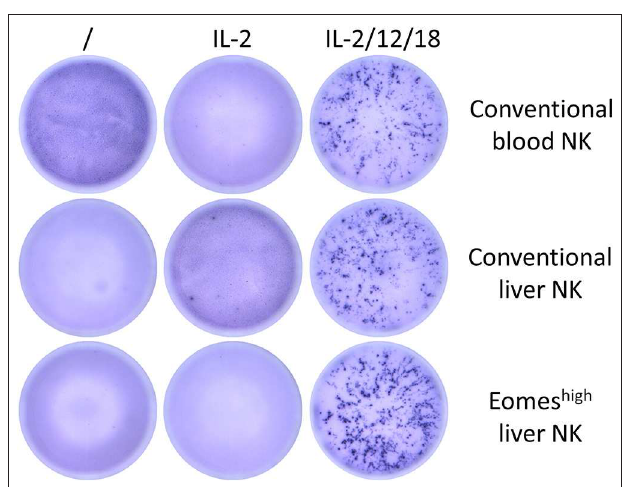
FIGURE 4 | IFN- γ production of conventional blood and liver NK cells or Eomes high liver resident NK cells upon stimulation with IL-2/12/18. After NK isolation, 1.25 × 10 4 NK cells/well were cultivated without stimulation or with different cytokine mixes for 20 or 38h and analyzed by ELISpot for their IFN- γ production. Picture shows data for one representative animal (analyzed at 20h post cytokine addition) out of five animals analyzed in total.